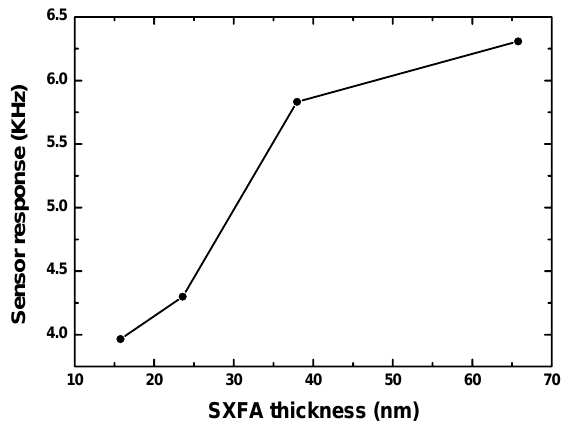
Figure 8. The measured effect of SXFA thickness on sensor